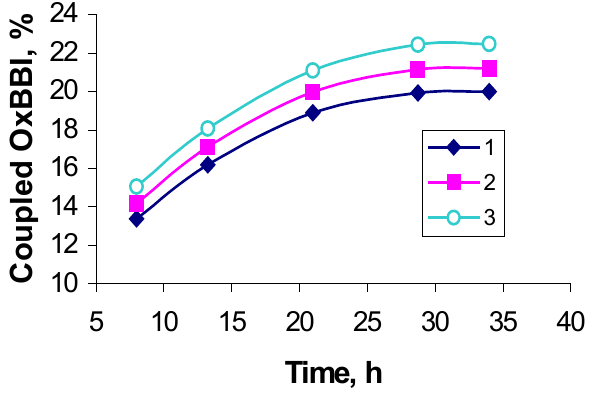
Figure 3. Influence of the reaction time on the coupled OxBBI ratio, at a gellan/OxBBI molar ratio = 0.35 mol/mol: 1 – DCCI/OxBBI = 1.1 mol/mol; 2 – DCCI/OxBBI = 1.25 mol/mol; 3 – DCCI/BBI = 1.4